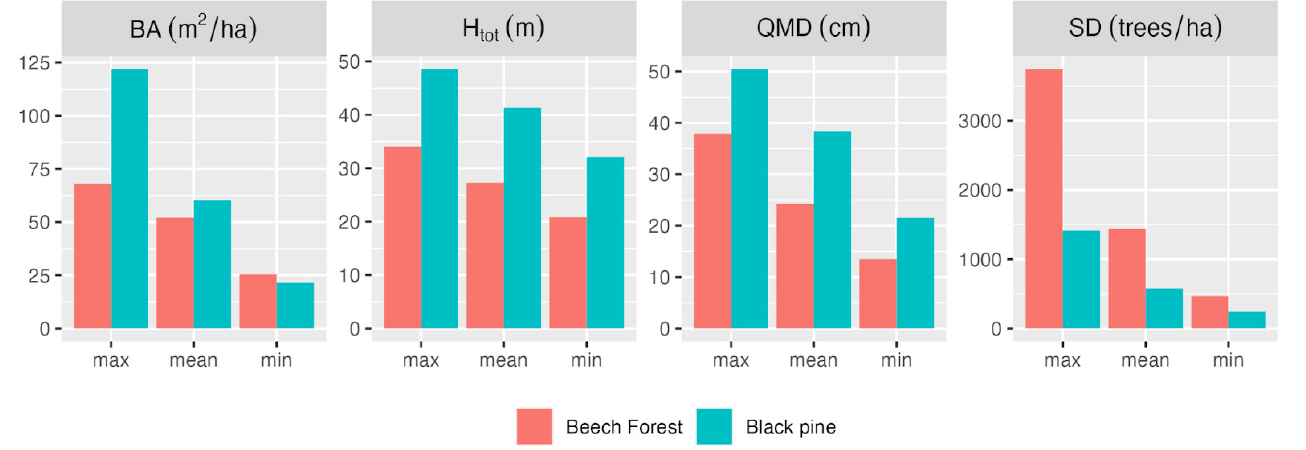
Figure 1. Plot locations and ALS tiles of the study area.